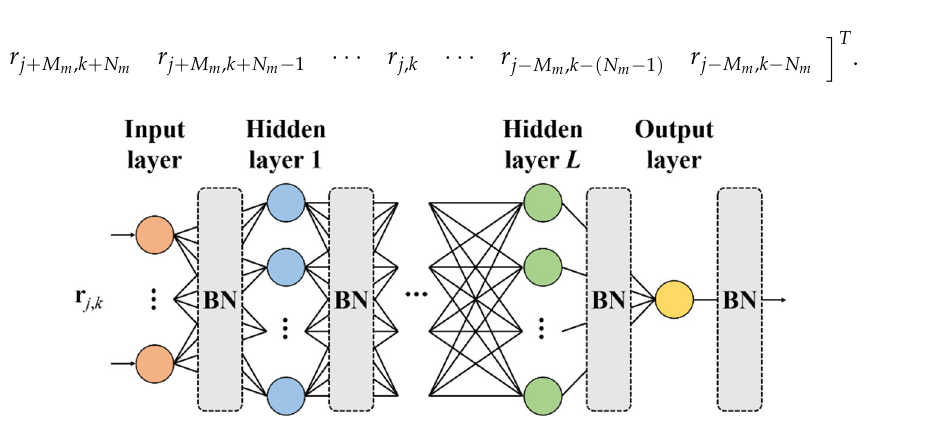
Figure 3. Configuration of the MLP detector.